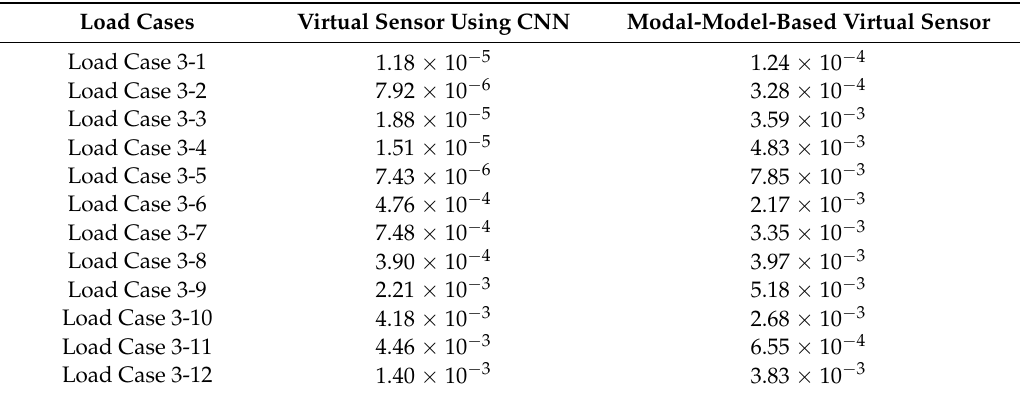
Table 12. Testing errors (MSE) of Load Case 3-1 to